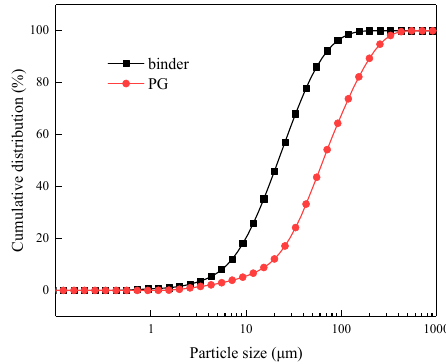
Figure 1. Particle size distributions of the phosphogypsum and binder. Table 1. Chemical compositions and physical characteristics of the phosphogypsum and binder. Chemical Composition